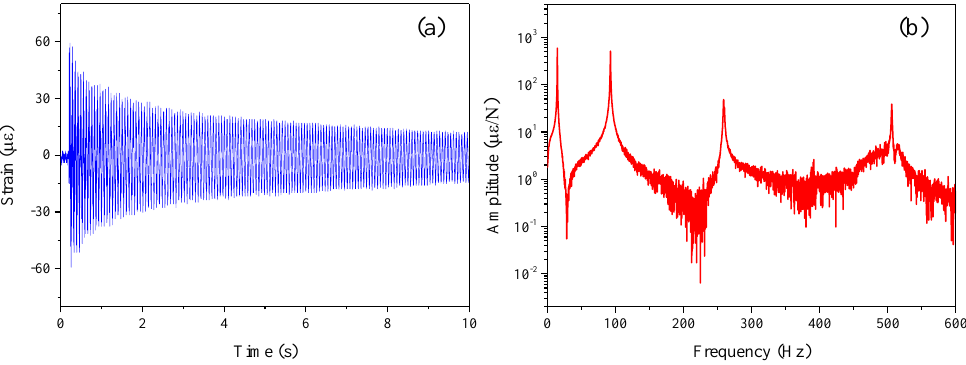
Figure 4. Signal of FBG sensor (FBG1). ( a ) strian response; ( b ) strian frequency response function.